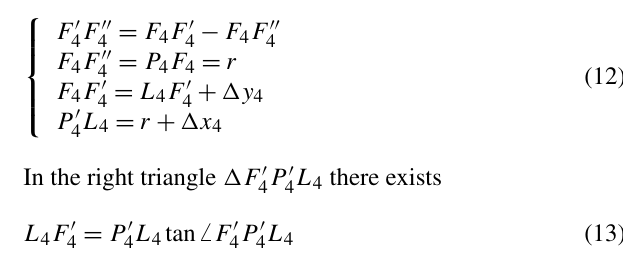
F (cid:48) F (cid:48)(cid:48) F (cid:48)(cid:48) , since F (cid:48) is the incremental part of the increased 4 4 4 4 step length with trunk twisting compared with that without the trunk